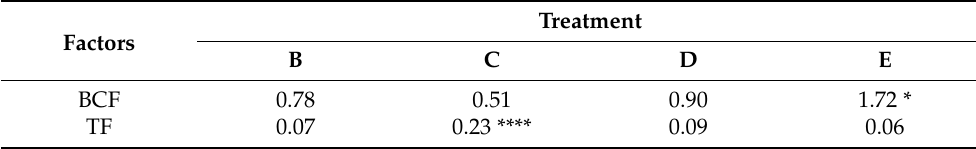
Table 2. Sb bioconcentration factor (BCF) and translocation factor (TF) for all treatments (star indicates the level of significance: * for p < 0.05, **** for p < 0.0001).